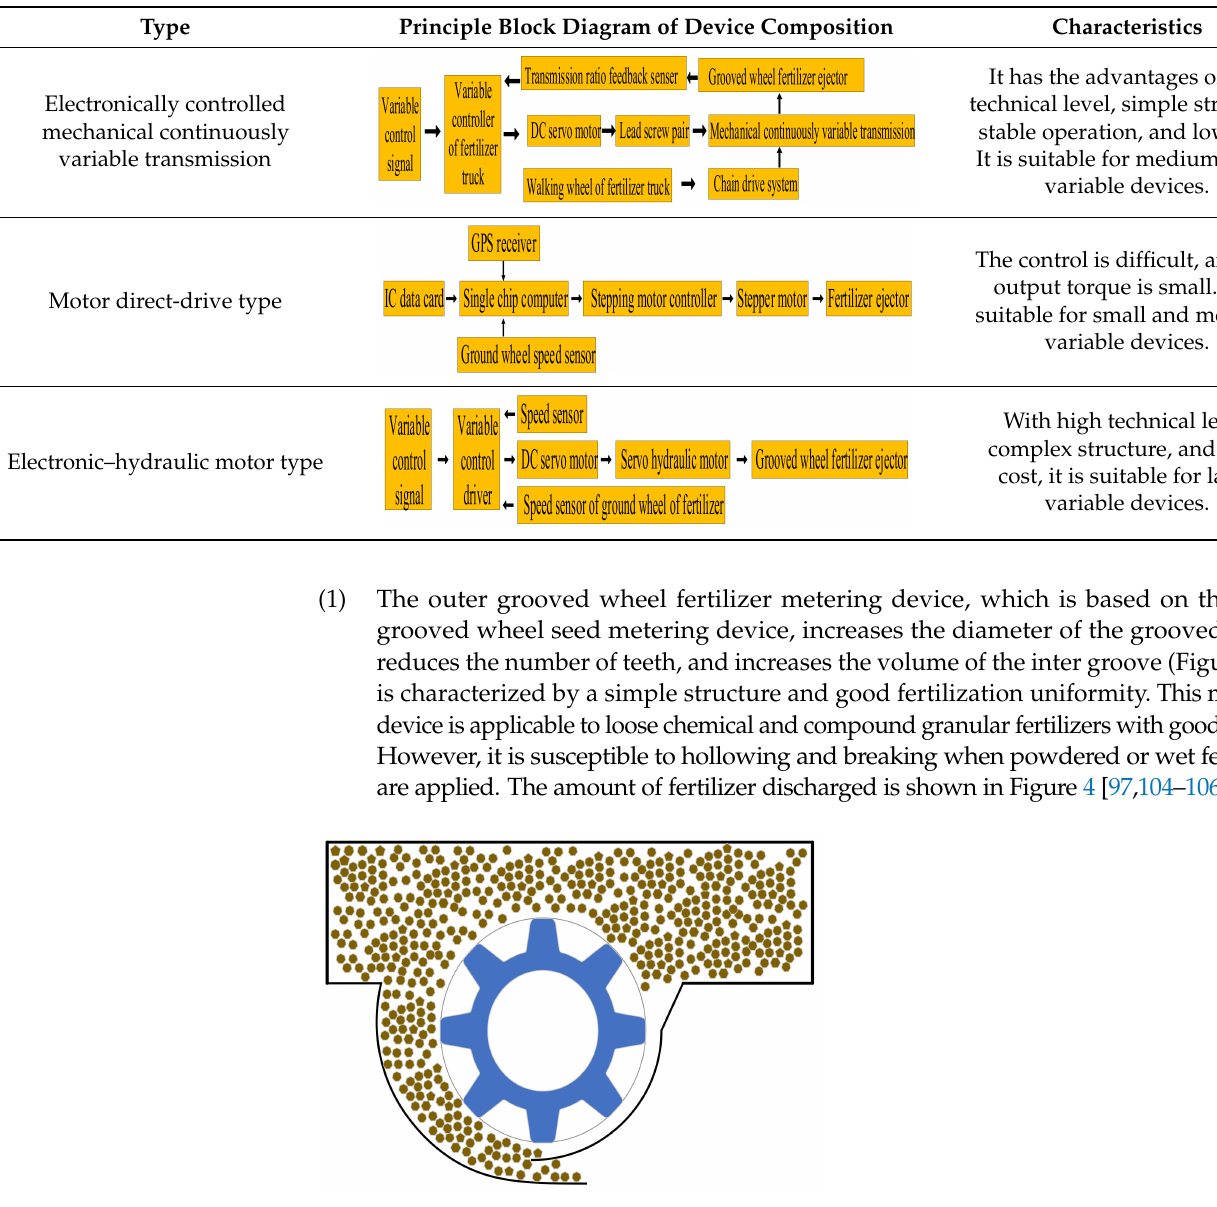
Figure 4. External grooved wheel fertilizer